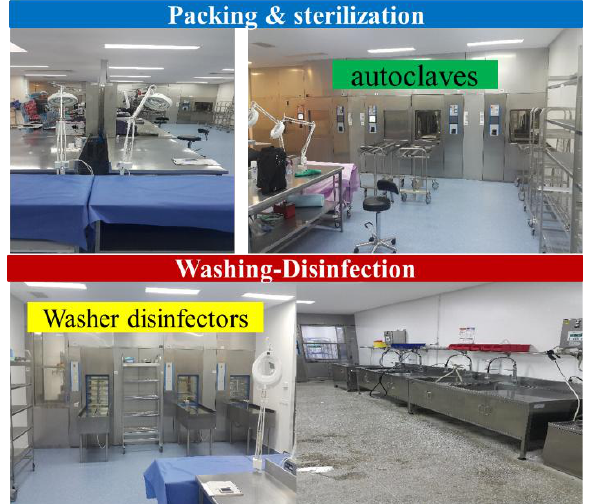
Figure 6 . Equipment and installation in disinfection and sterilization zones in CSSD-UH of Oujda city. Table 3. Energy-saving comparison of ohmic and